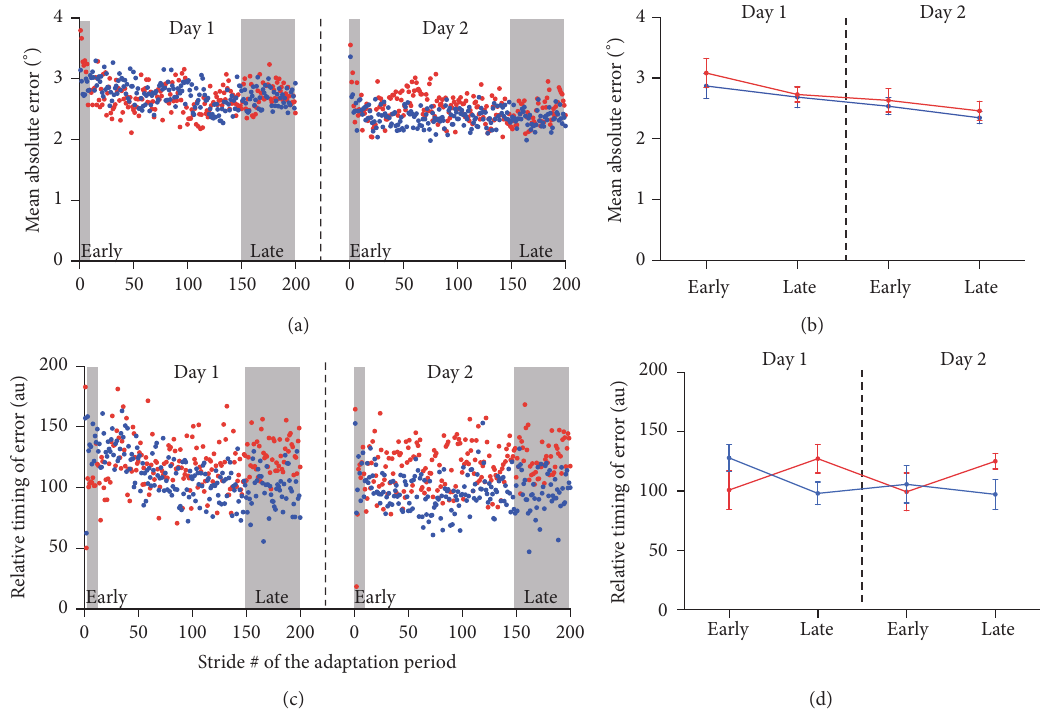
Figure 3: Results for ankle kinematic outcome measures: (a) and (c) present Control (blue) and Pain (red) group averaged time course of the mean absolute error (a) and relative timing of error outcome measures (c) for each day. Gray areas highlight the strides used for the computation of early and late adaptation presented in (b) and (d) (mean ±